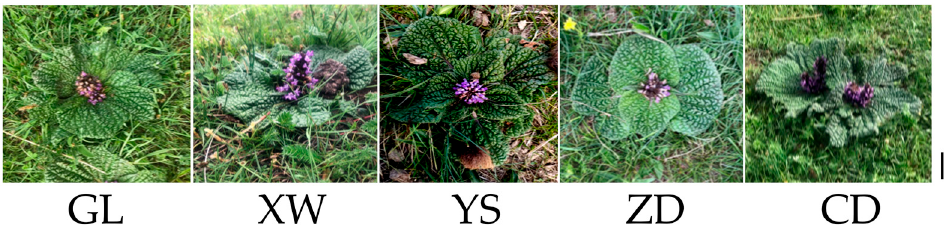
Figure 1. L. rotata in five different habitats. GL: Guoluo county in Qinghai province; XW: Xiewu county in Qinghai province; YS: Yushu county in Qinghai province; ZD: Zaduo county in Qinghai province; CD: Chengduo county in Qinghai province. Bar = 2 cm. Table 1. The habitat and site of L. rotata from five regions.